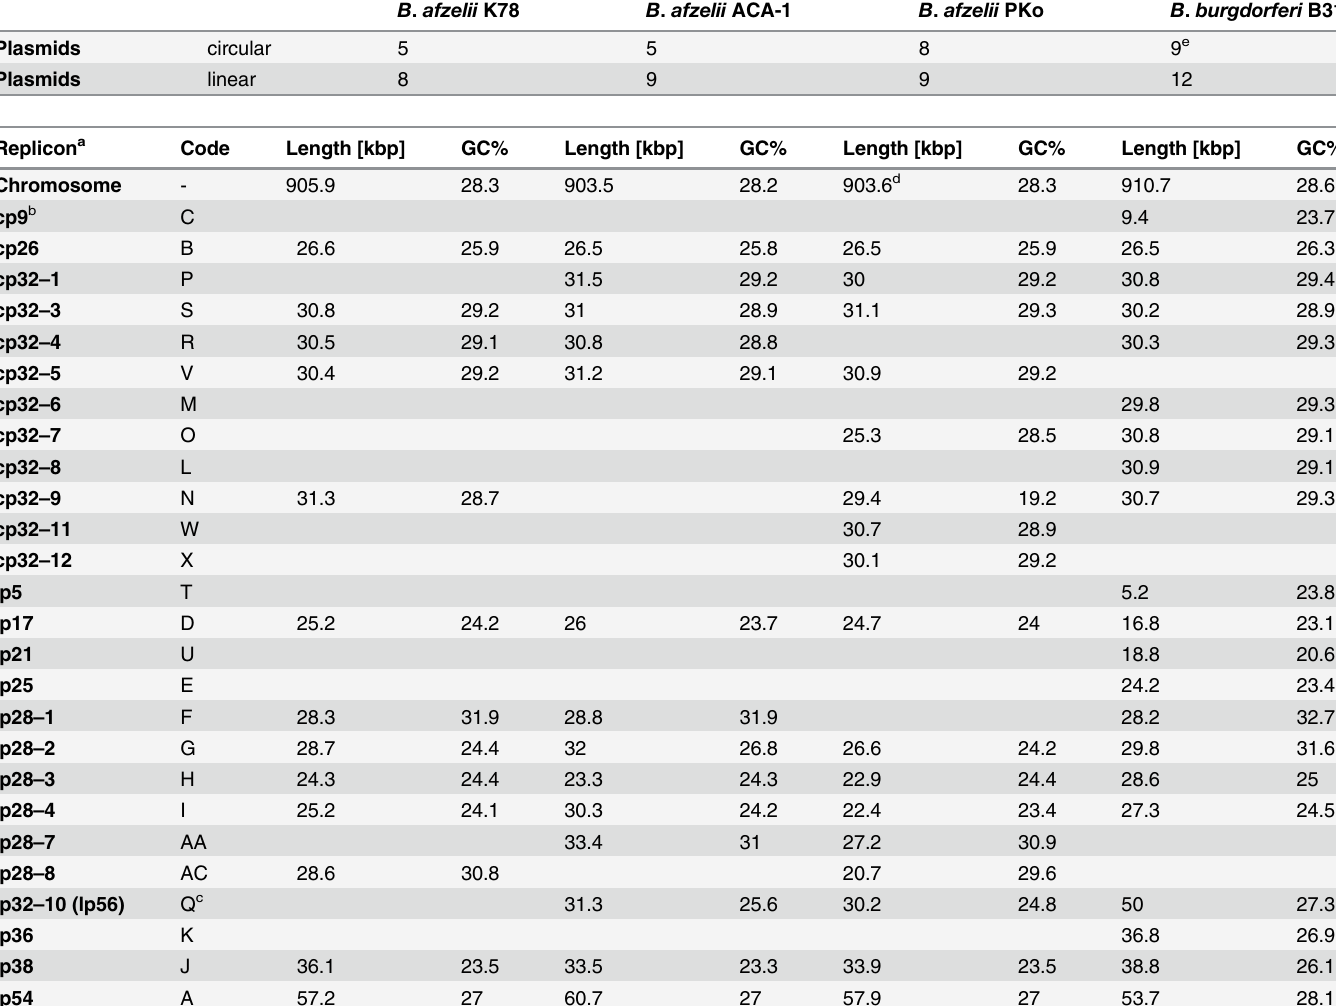
Table 2. Comparison of the replicons found in Borrelia afzelii K78 to the published sequences of B . afzelii strains ACA-1, PKo and B . burgdorferi strain